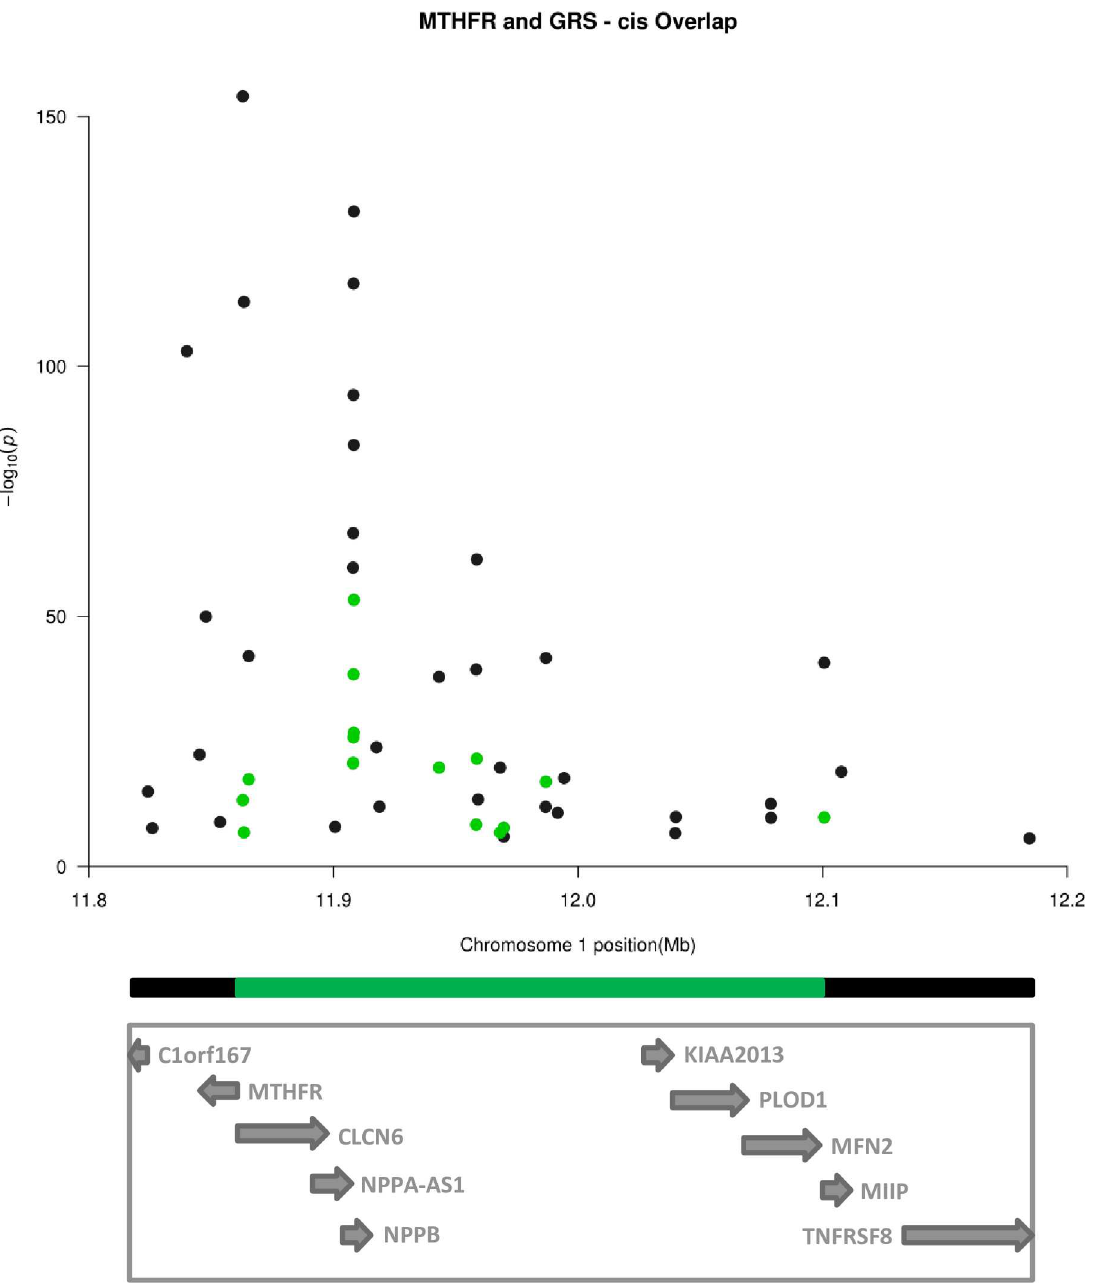
Fig 3. Regional manhattan plot (chr1: 11824095–12184574). 35 (black) and 16 (green)cis-meQTLs of the MTHFR 677C > T and GRS model respectively,in 9,894 samples. The overlapinvolveda small regionof 238 kb (green rectangular line). model were at a distance between 1 and 5 Mb away from the Hcy-associated variant rs548987 of the SLC17A3 gene at chromosome 6 [Table a in S6 Table]. Conditional analysis: Chromosome 6 region near rs548987. To investigate whether the 14 trans -CpGs on chromosome 6 near rs548987 were influenced by this variant, we performed conditional analysis on a subset of 3,786 samples from 6 cohorts. After correction of the model